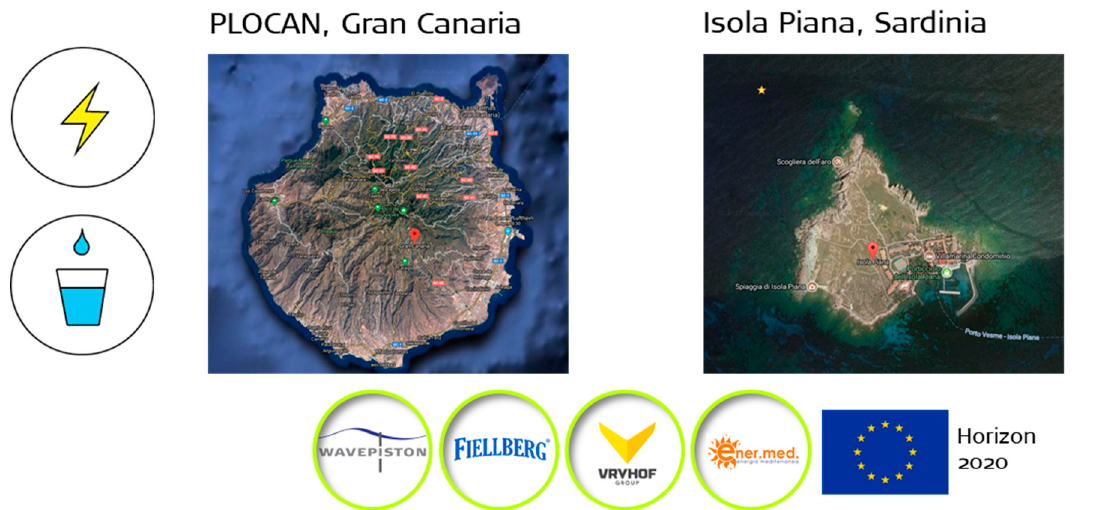
Figure 4. Sites of demonstration phase projects.